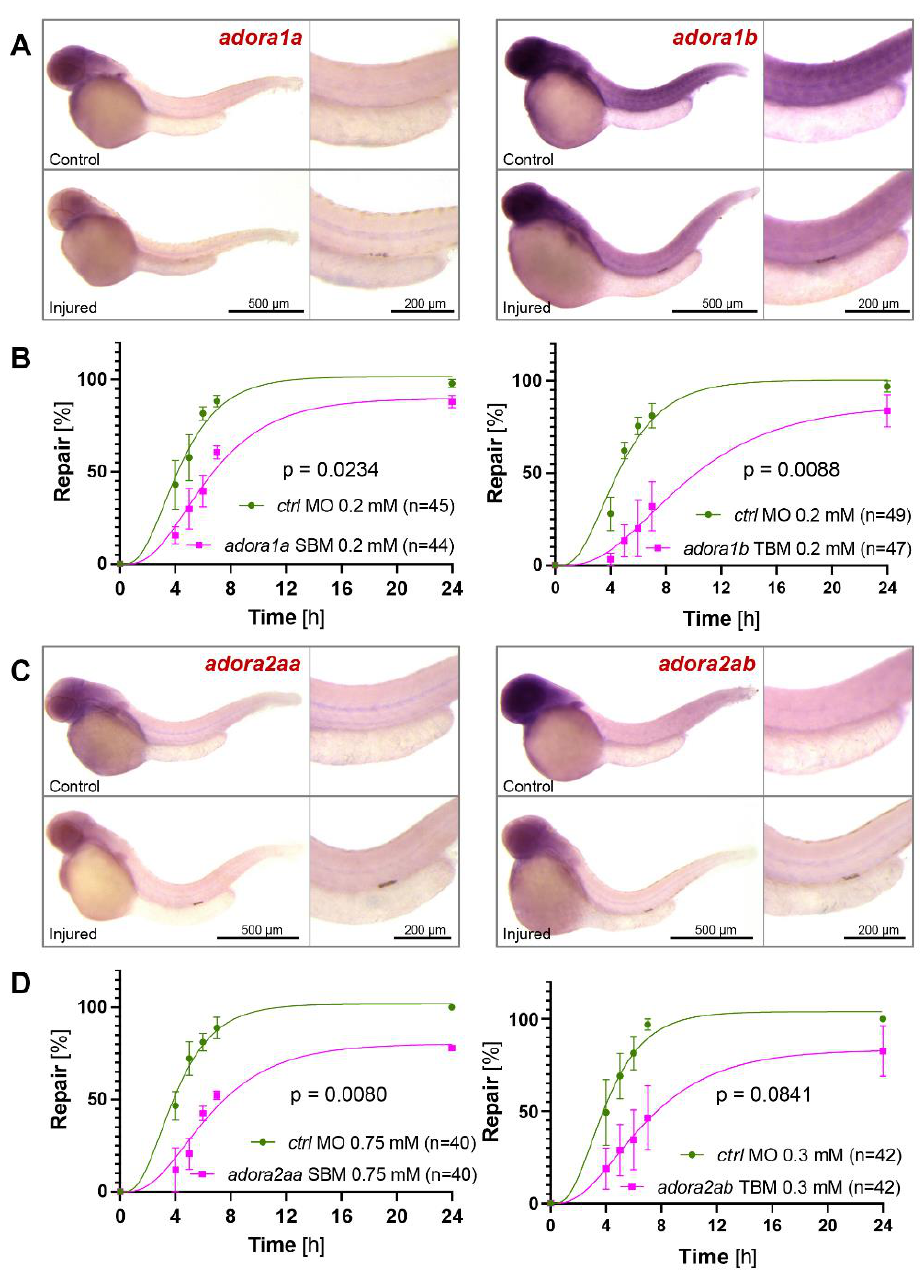
Figure 1. The involvement of adenosine receptors in zebrafish pronephros repair. ( A ) In situ hybridization revealed upregulation of zebrafish adora1a and adora1b after a laser-induced injury. Images were obtained two hours after the injury. ( B ) Depletion of zebrafish adora1a or adora1b by splice- (SBM) or translation- (TBM) blocking morpholino oligonucleotides (MO) delayed the repair process. ( C ) In situ hybridization revealed upregulation of zebrafish adora2aa and adora2ab after a laser-induced injury. Images were obtained two hours after the injury. ( D ) Depletion of zebrafish adora2aa or adora2ab by SBM delayed the repair process (mean ± SEM; 2-way ANOVA).